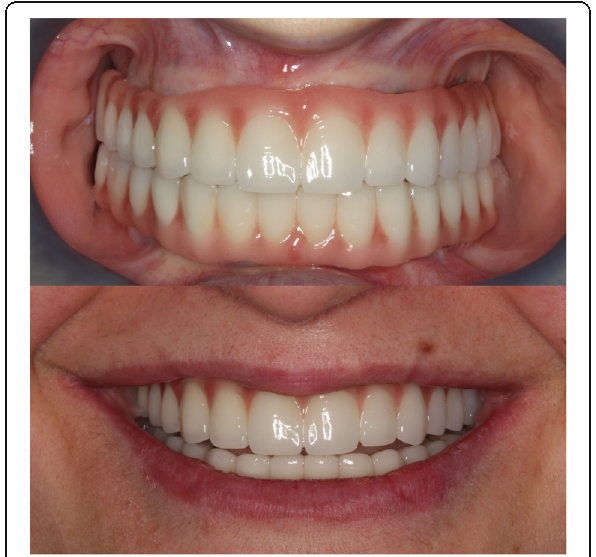
Fig. 5 Provisional prosthesis in the same day with surgery Fig. 6 Definitive prosthesis of